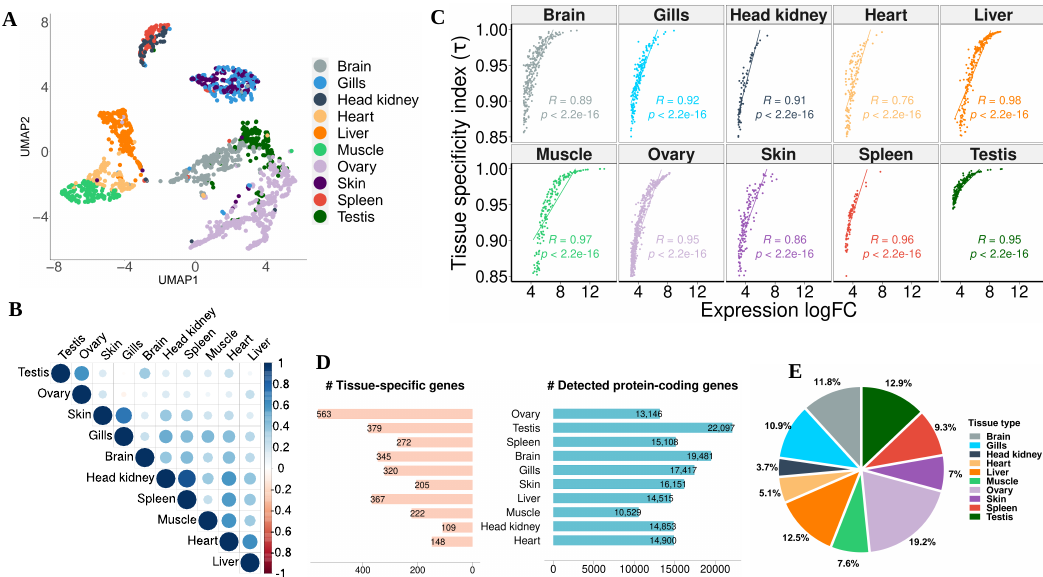
Figure 4. Statistics on tissue-specific genes of Sander lucioperca . ( A ), Uniform Manifold Approximation and Projection (UMAP) clustering of 2930 tissue-specific genes in pikeperch based on their expression levels (TPM), where clusters represent genes with similar or correlated expression. ( B ), Correlation heatmap between tissues, based on their specific transcriptome profile. ( C ), Spearman correlation between expression fold-change for each tissue vs. all, and the index of tissue specificity ( τ ). R is the spearman correlation coefficient and p the corresponding p -value. ( D ), Number of detected and tissue-specific genes in each tissues. ( E ), Percentage distribution of tissue-specific genes across tissues.